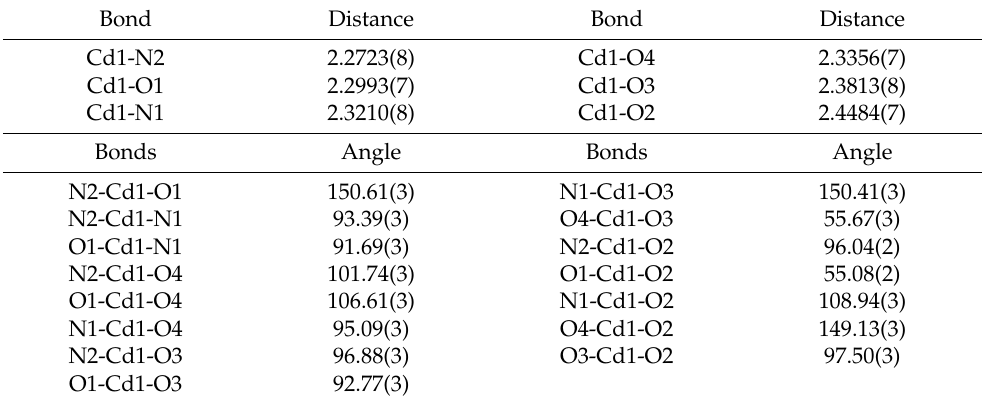
Figure 6. The asymmetric unit of [Cd(OAc) 2 (2Ampic) 2 ] ( 3 ). Table 4. The important geometric parameters (Å, ◦ ) in complex 3